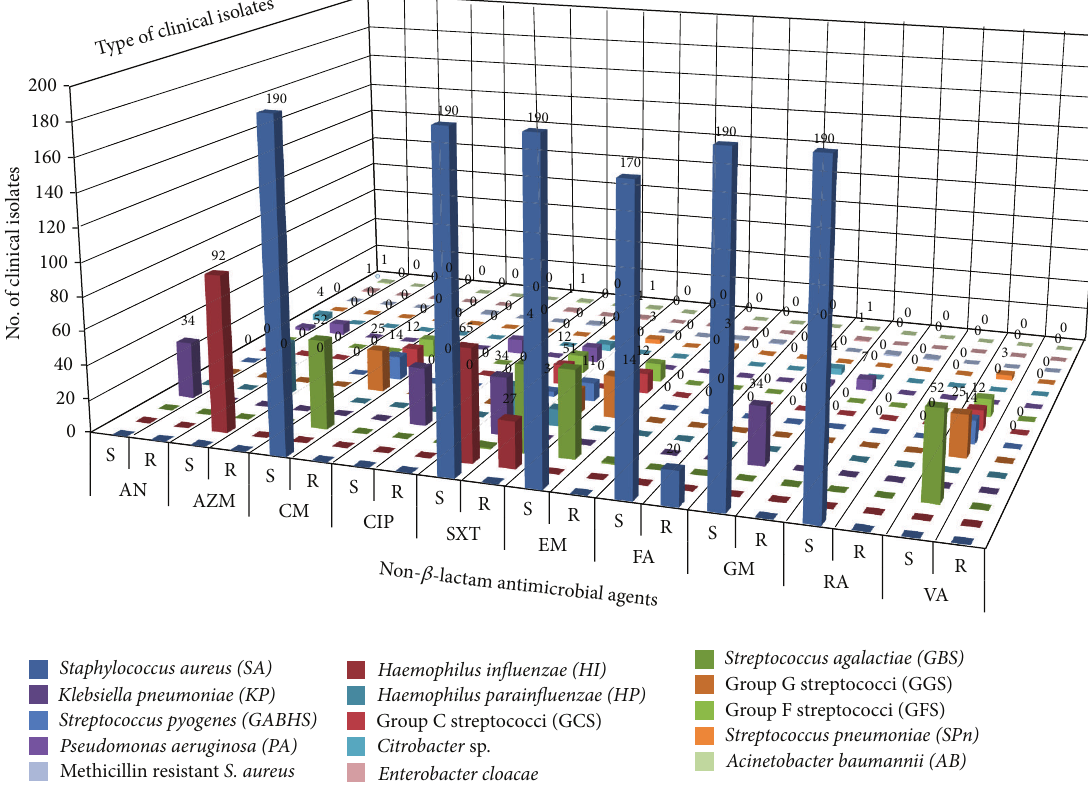
Figure 2: Antimicrobial susceptibility of tonsillar isolates against selected non- 𝛽 -lactam agents. AN: amikacin, AZM: azithromycin, CM: clindamycin, CIP: ciprofloxacin, SXT: co-trimoxazole, EM: erythromycin, FA: fusidic Acid, GM: gentamicin, RA: rifampin, VA: vancomycin. (S) indicates susceptible isolates and (R) indicates resistant